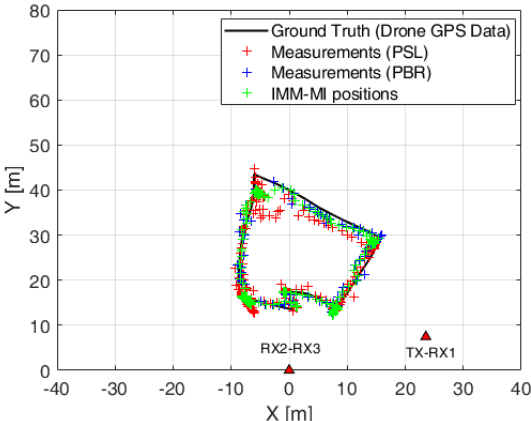
Figure 17. Localization and tracking of the drone on the x-y plane with IMM-MI (Sensor Fusion).